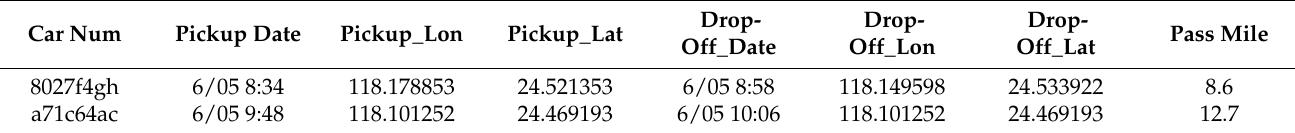
Figure 2. Location of the study area. Table 1. Sample records of travel